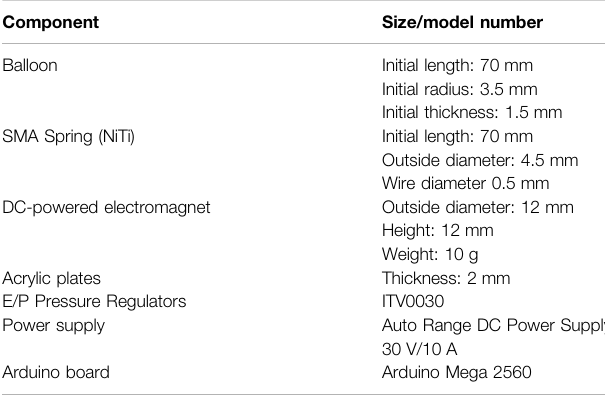
TABLE A1 | The detailed parameters of the robot segment ’ s